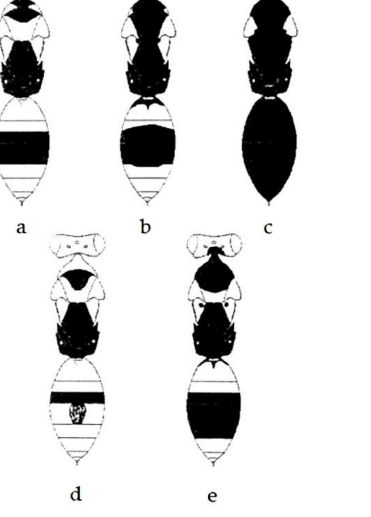
Figure 2. Scheme of chromatic variation of C. pictus body observed in the five classes: ( a ) class I = yellow females, ( b ) class II = yellow–black females, ( c ) class III = black females, ( d ) class IV = yellow males, ( e ) class V = black